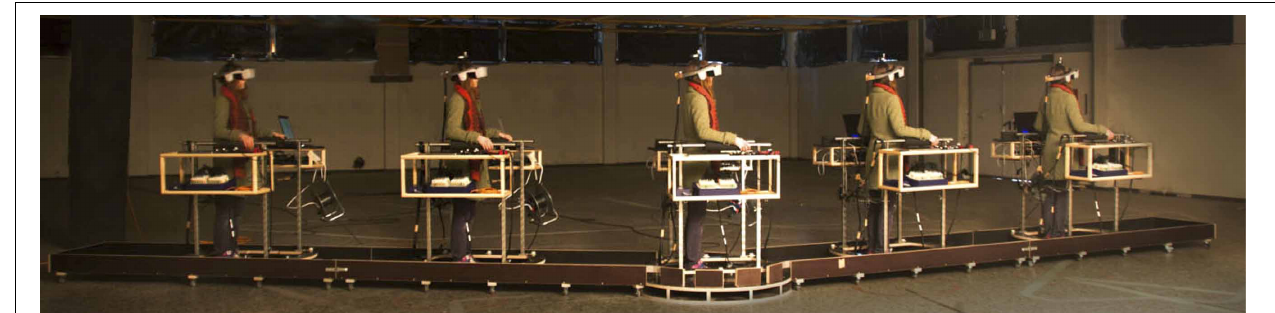
FIGURE 1 | Walkway. We devised a flexible walkway consisting of two straight segments that are connected by a turnable platform. Subjects were wearing an EEG cap (not shown in the picture)